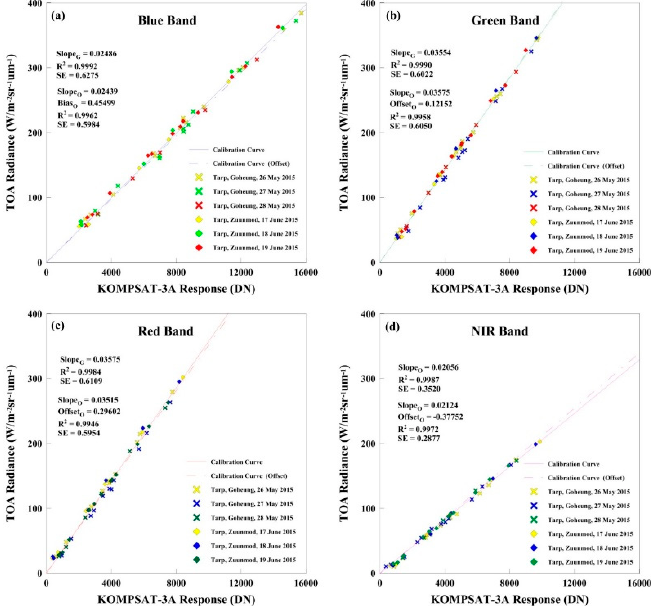
Figure 4. Absolute calibration conducted using a vicarious approach.